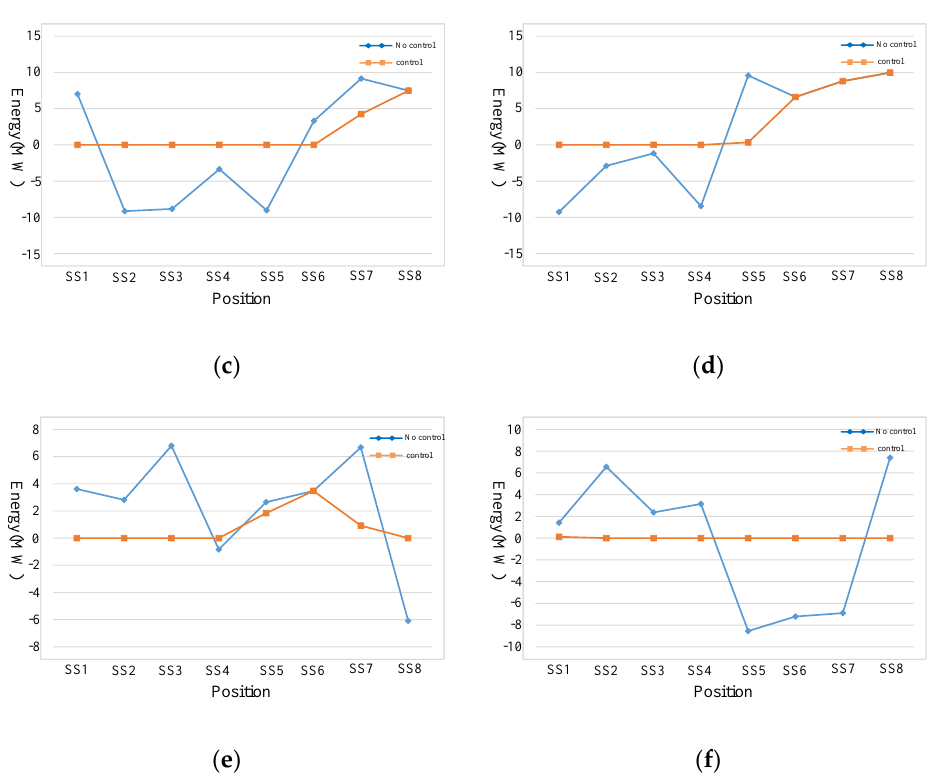
Figure 18. Partial comparison results before and after control: ( a ) 60th group; ( b ) 61th group; ( c ) 62th group; ( d ) 63th group; ( e ) 64th group; and ( f ) 65th group.